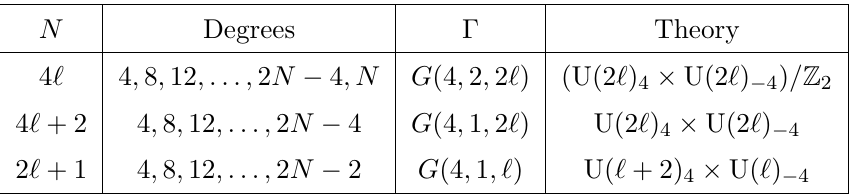
Table 15 . Theories obtained by compactifying so (2 N ) SYM via a twist by N 4 R 4 . The result depends on the value of N modulo 4. In all cases we obtain theories of ABJ